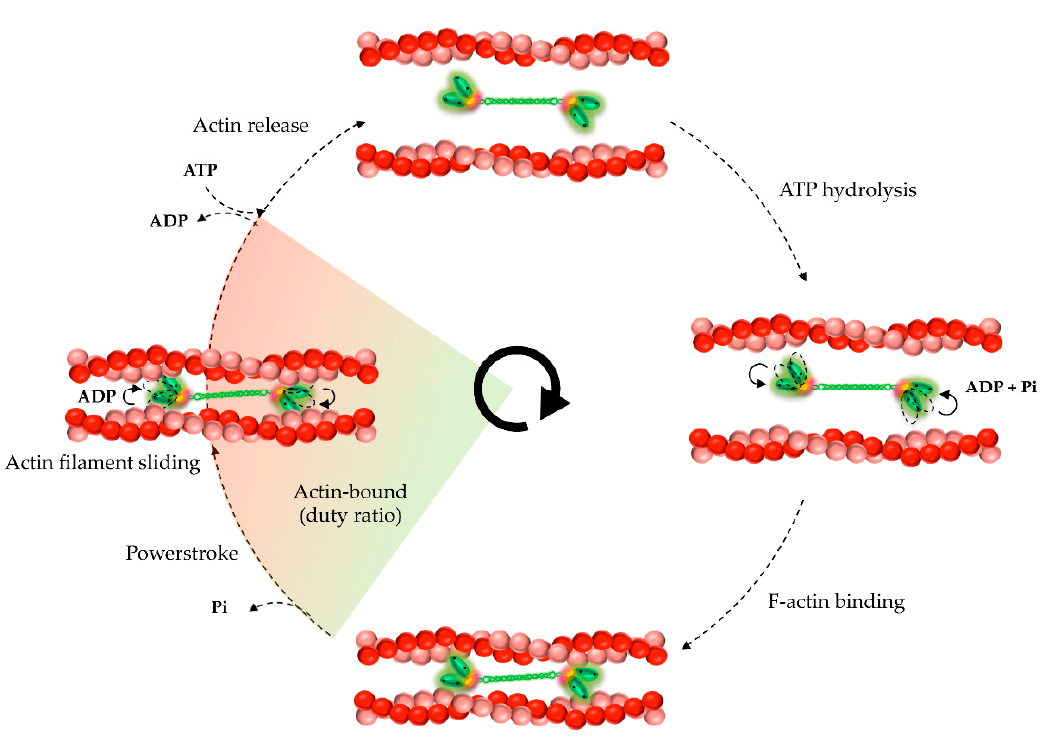
Figure 4. Schematic model for NM2-dependent actin sliding cycle. ATP binding dissociates NM2 from actin (actin release). Myosin motor head hydrolyzes ATP and re-attaches to actin. The release of the phosphate (Pi) triggers a conformational change that promotes movement and powers the contraction of actin filaments (powerstroke). The colored region corresponds to the portion of the cycle during which the NM2 motor head is strongly bound to actin, this is called duty ratio. The exchange of ADP by ATP restarts the cycle. This figure was adapted from